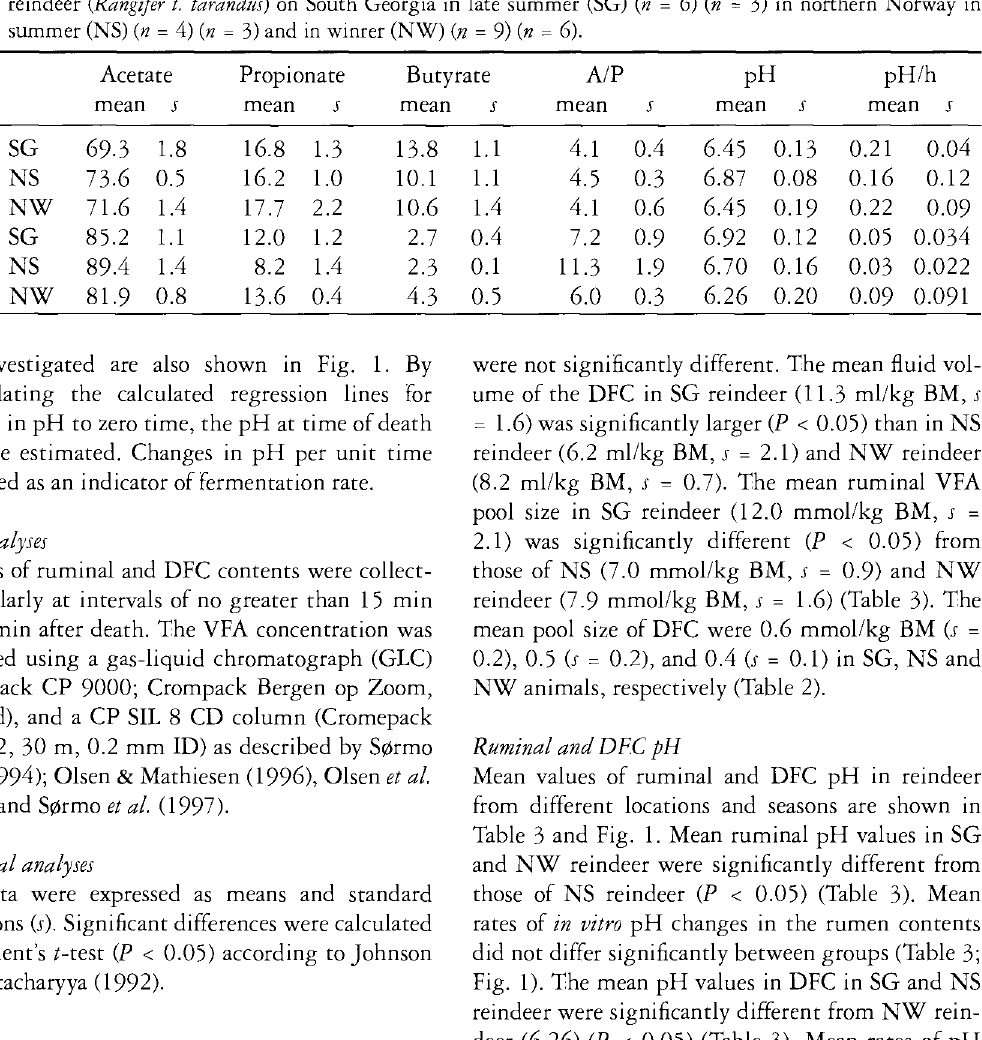
Table 3. Mean (s = standard deviation) molar proportion (%) of acetate, propionate and butyrate and the acetate/propi- onate (A/P) ratio and pH in the ruminal and DFC contents (distal fermentation chamber), respectively, in reindeer (Rangifer t. tarandus) on South Georgia in late summer (SG) (» = 6) (« = 3) in northern Norway in summer (NS) (» = 4) (» = 3) and in winrer (NW) (n = 9) (« = 6). Acetate Propionate Butyrate